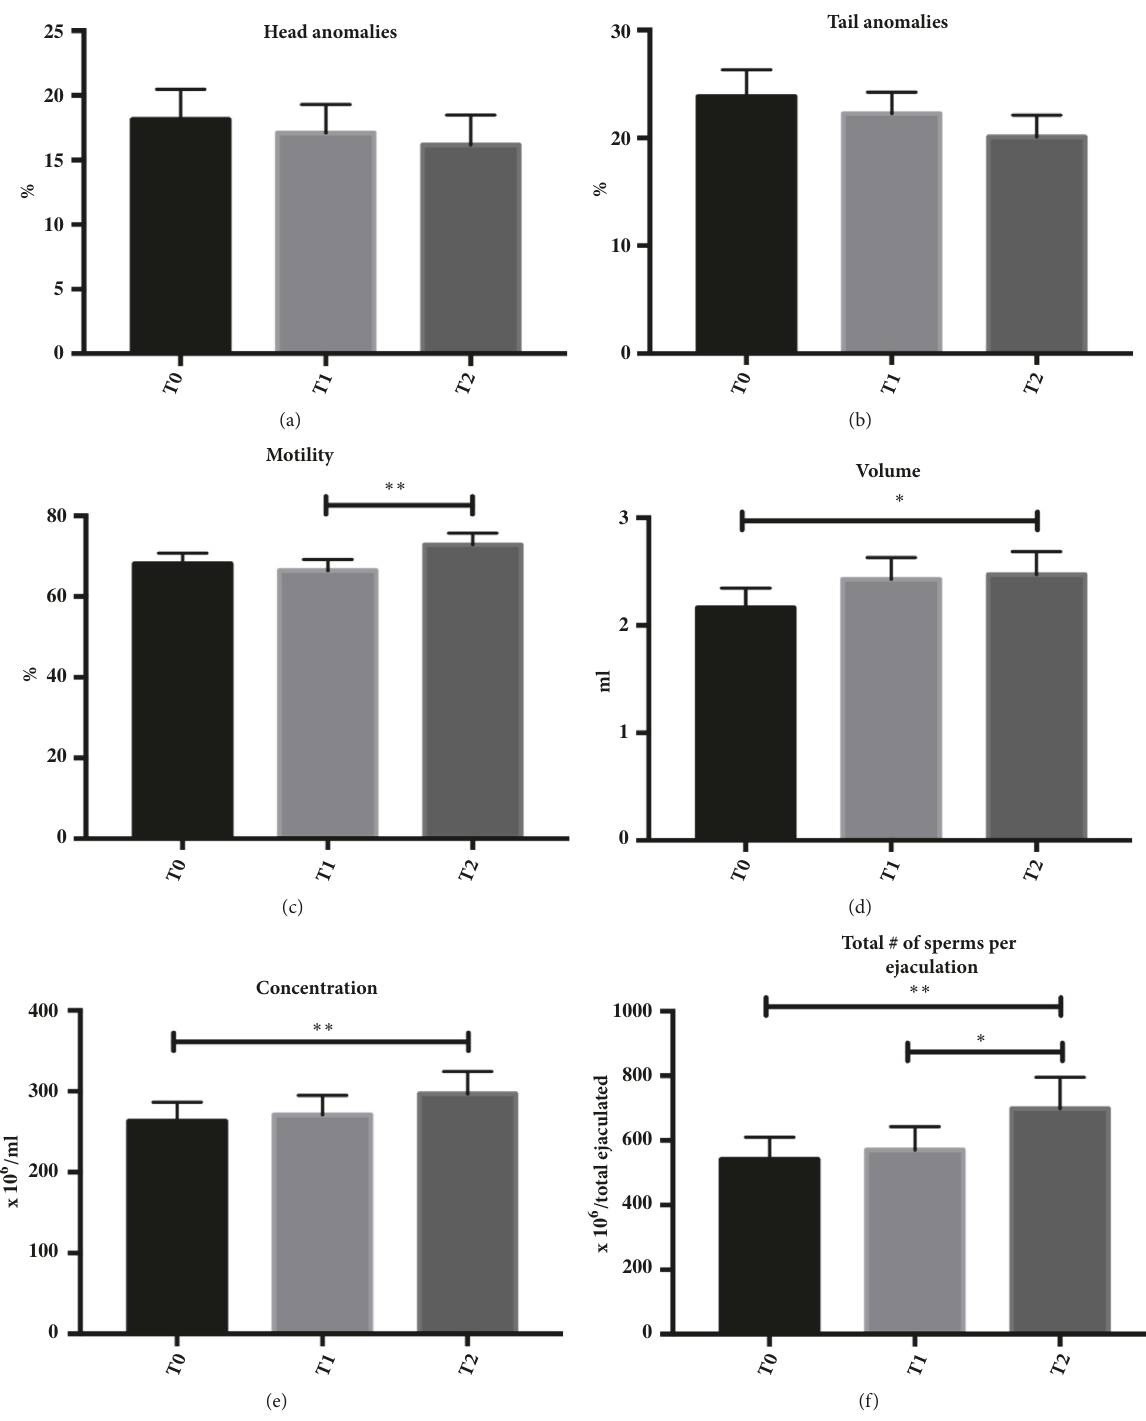
Figure 1: Graphical representation of spermatic volume, concentration, and motility, as well as the total number of sperms per ejaculation and the percentage presence of tail and head anomalies in dogs supplemented with the nutraceutical diet. ∗ p < 0.05; ∗∗ p < 0.01.